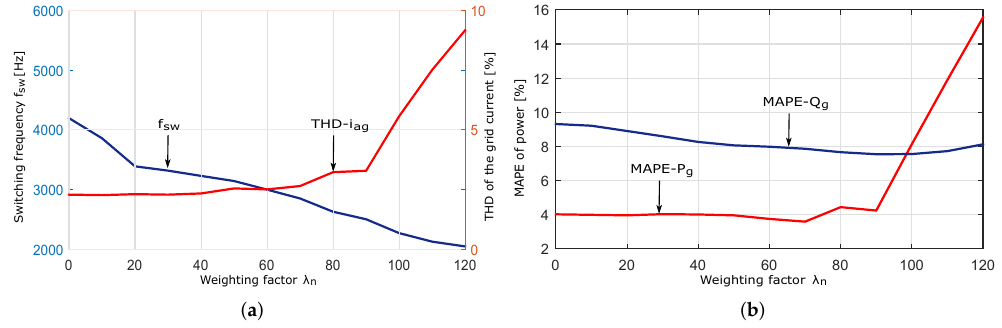
Figure 12. Weighting factor impact on: ( a ) the THD of the grid current and switching frequency; and ( b ) the power ripple.